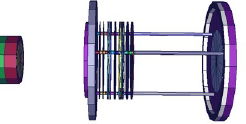
Figure 3. The irradiation setup, as it was described in the MCNP5 simulation (the cap of the chamber is excluded in this figure so that its interior can be seen).